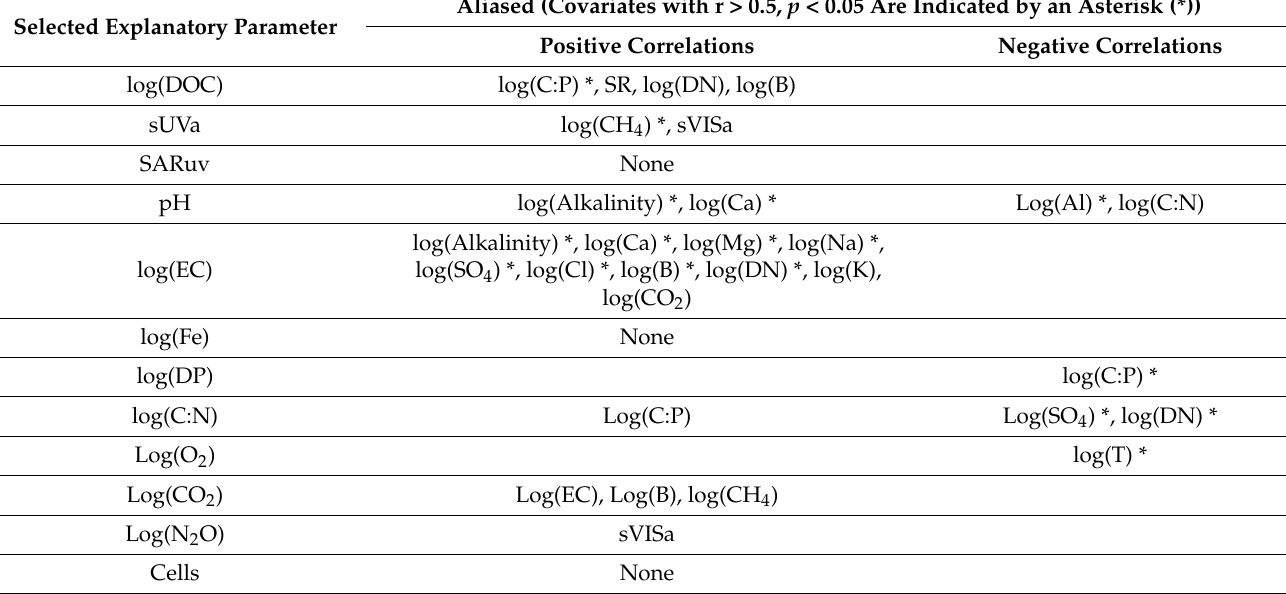
Table 2. Selected 12 explanatory parameter and their aliased